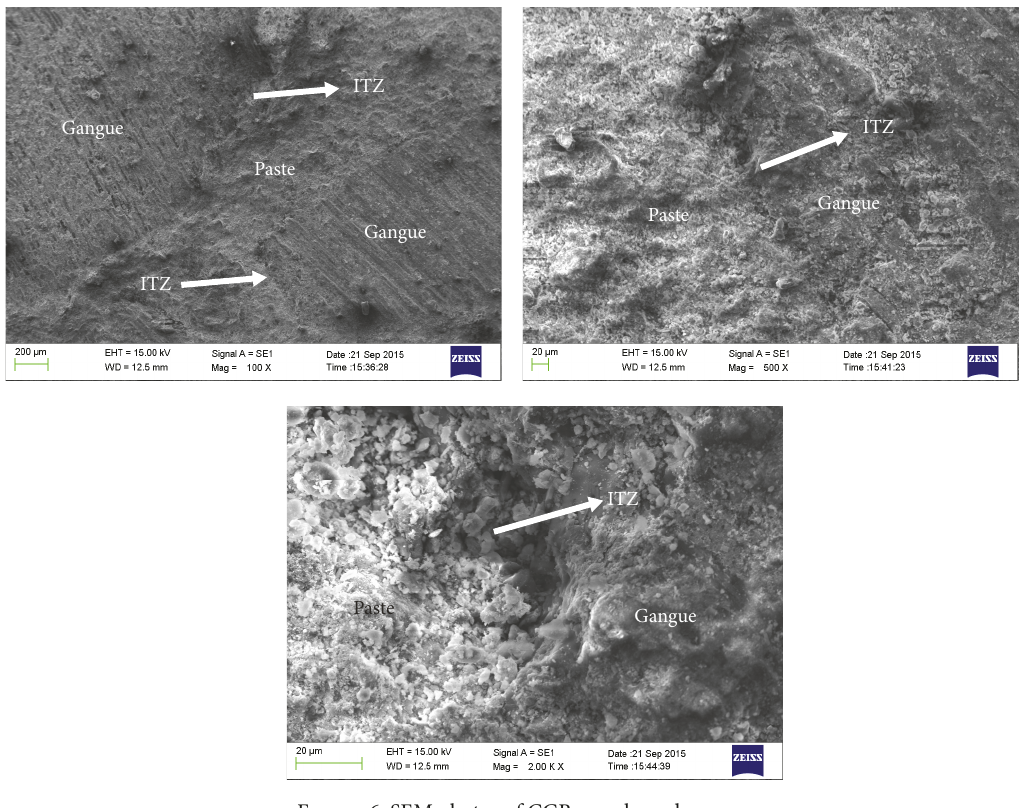
Figure 6: SEM photos of CGB sample under 𝜎 𝑎 .